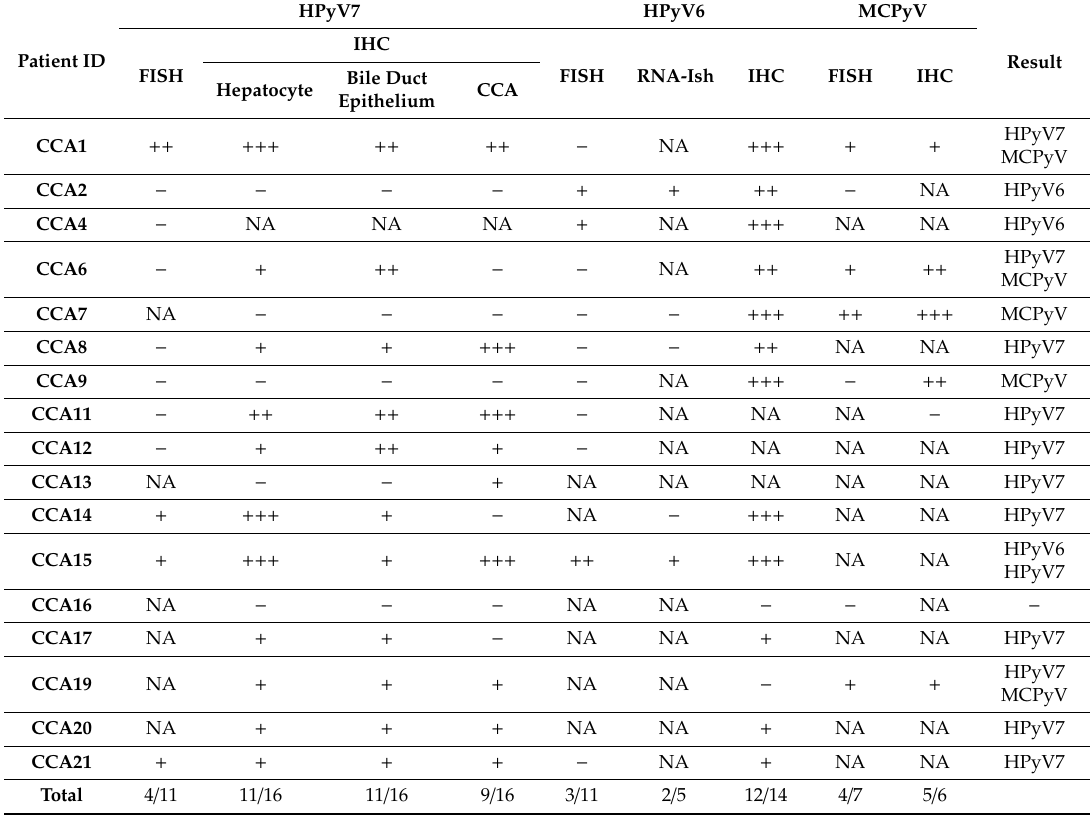
Table 2. Fluorescence in situ hybridization, immunohistochemistry, and RNA in situ hybridization results.